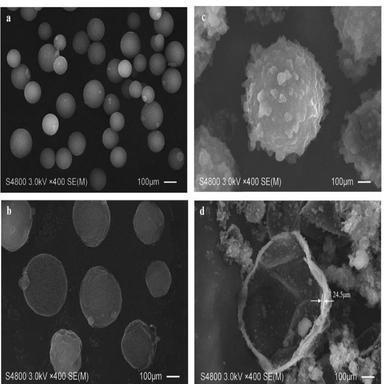
SEM image of microcapsules: (a) MC1, (b) MC2, (c) MC3, (d) fractured MC3.